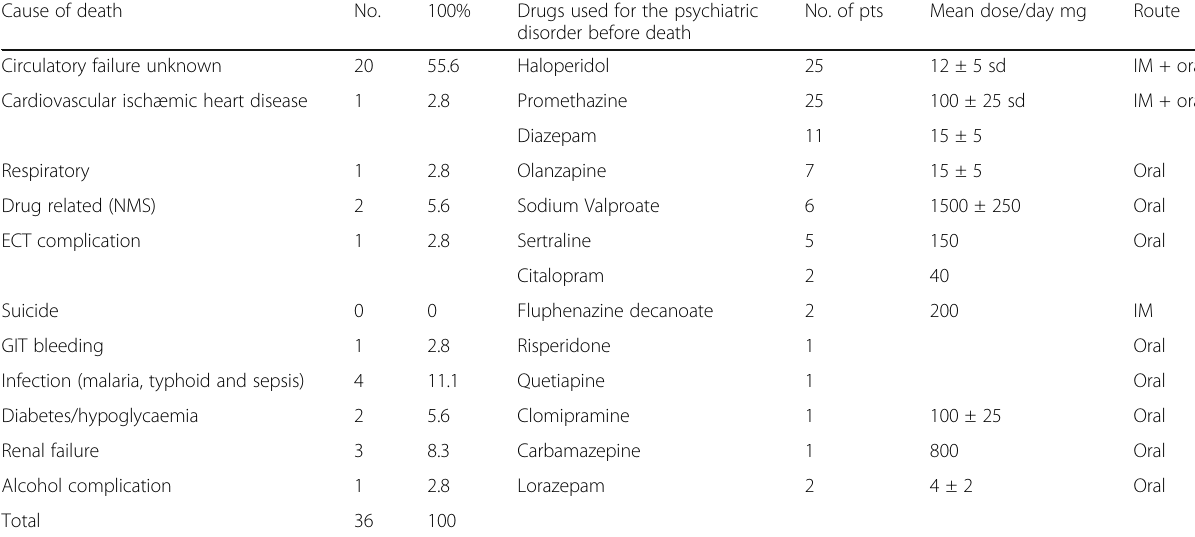
Table 2 Causes of mortality and psychiatric drug treatment before